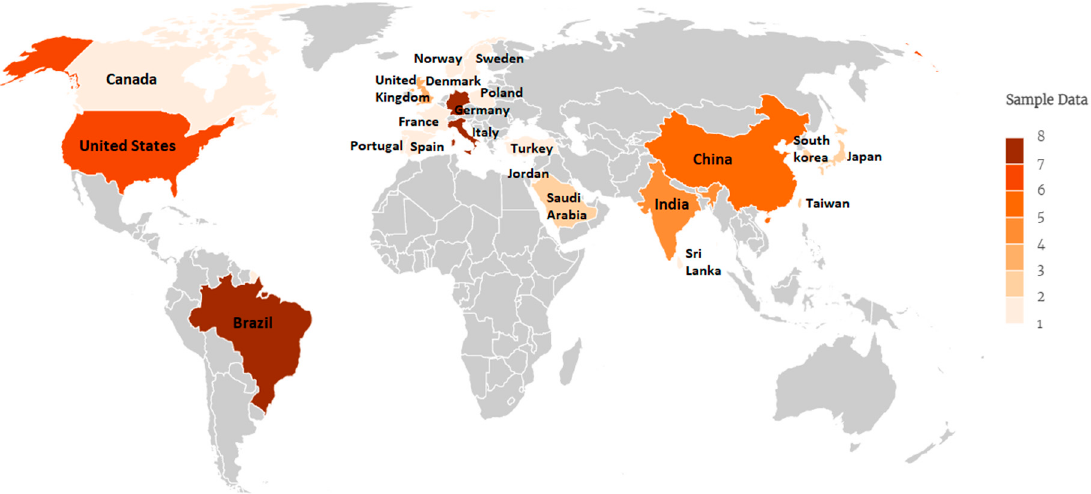
Figure 4. I4.0 and LSS integration research by countries.